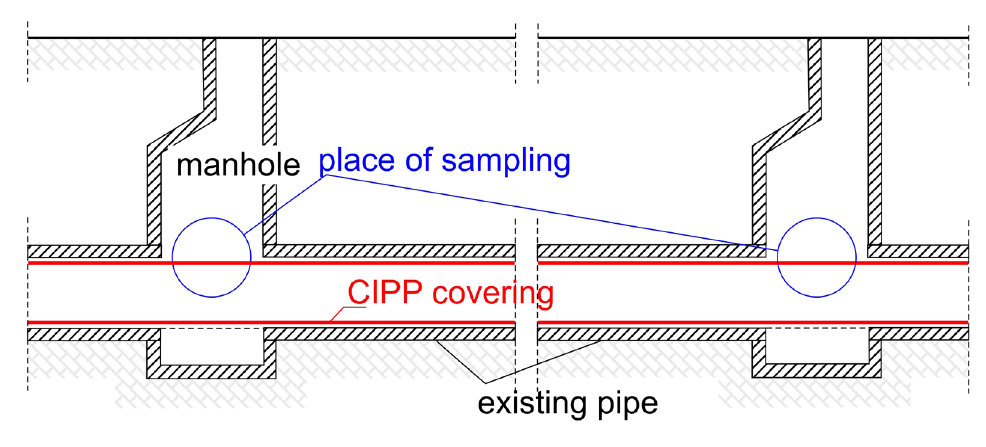
Figure 3: An overview sketch of the liner’s